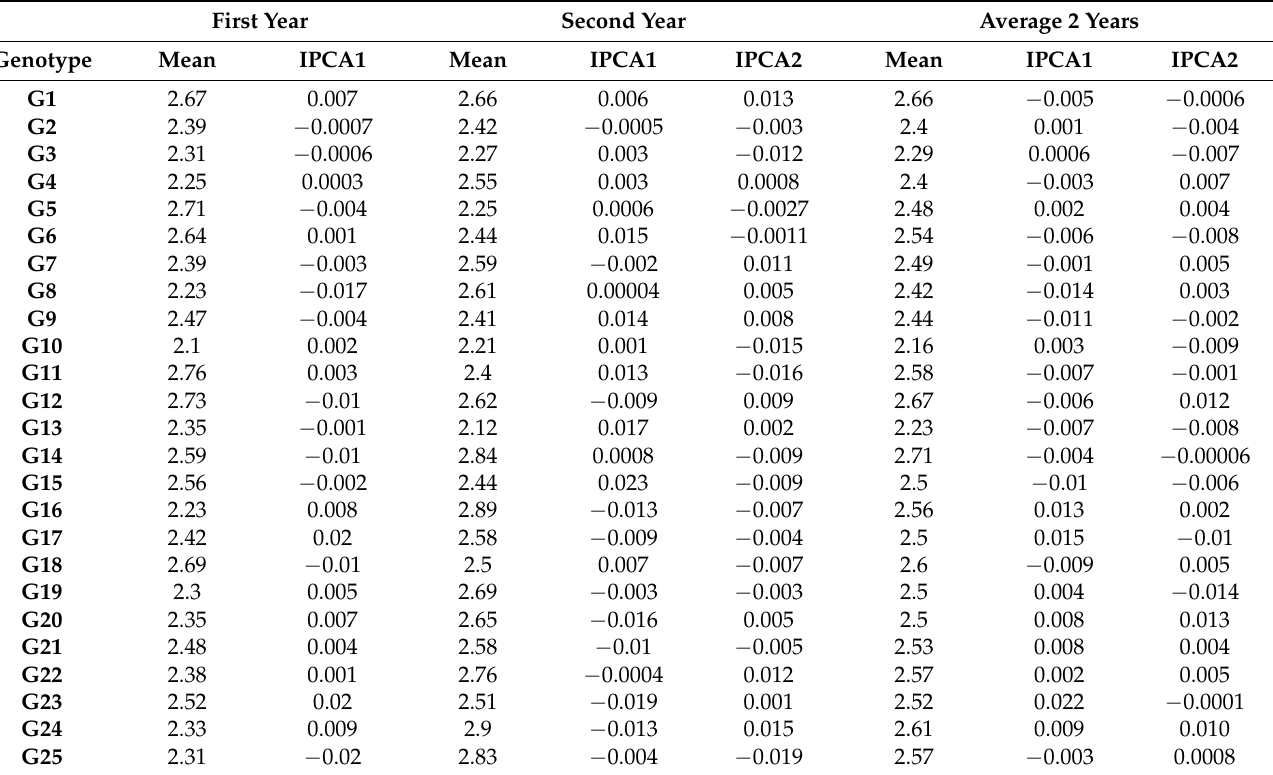
Table 6. Average value, first main component, and second main component in 25 wheat genotypes in the first, second and average of two crop